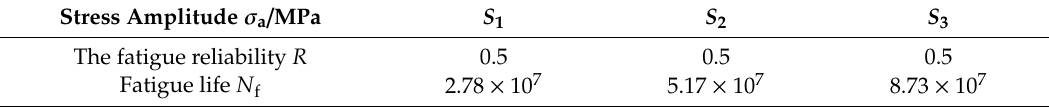
Table 4. Stress amplitude, fatigue reliability, and fatigue